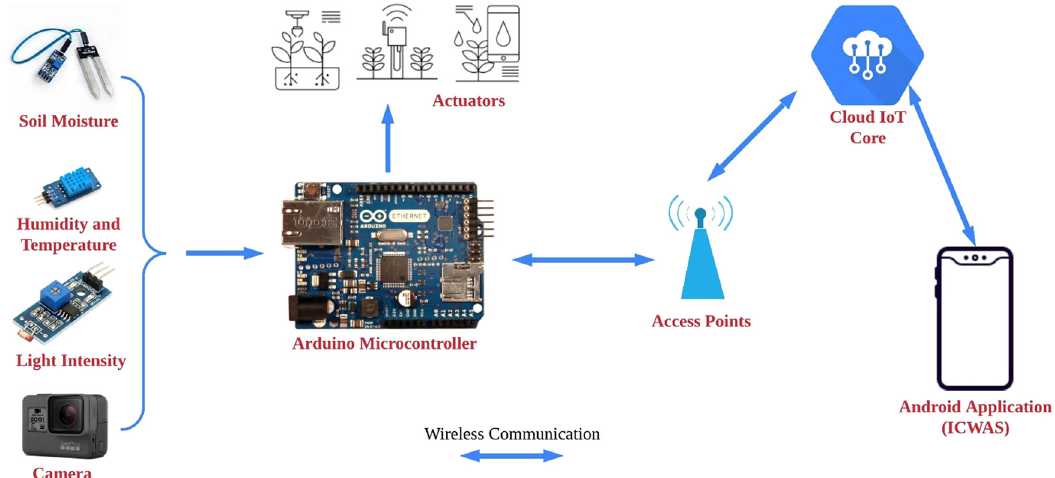
Figure 3: Hardware implementation of proposed system ( ICWAS )